Question: In a single sentence, describe what this figure presents.
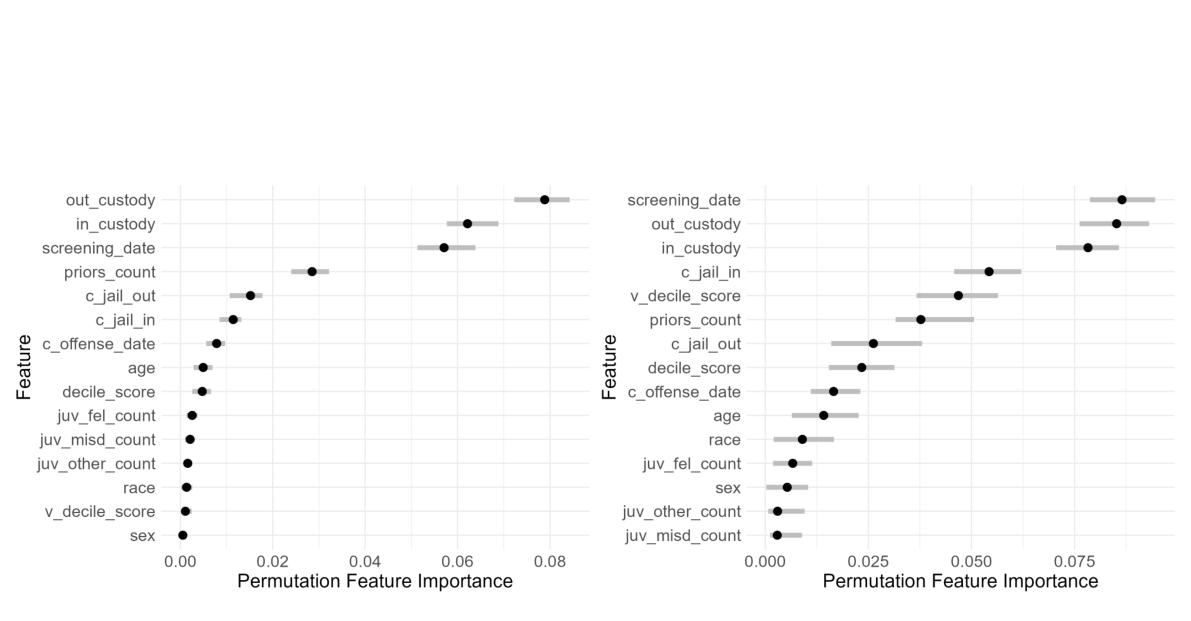
Answer: Permutation Feature Importance for f(x) before Attack (Left) and a(x) after Attack (Right), COMPAS Data. The grey lines represent the range from the 10th to the 90th percentile of PFI estimates across fifty runs, with median values indicated by black dots.